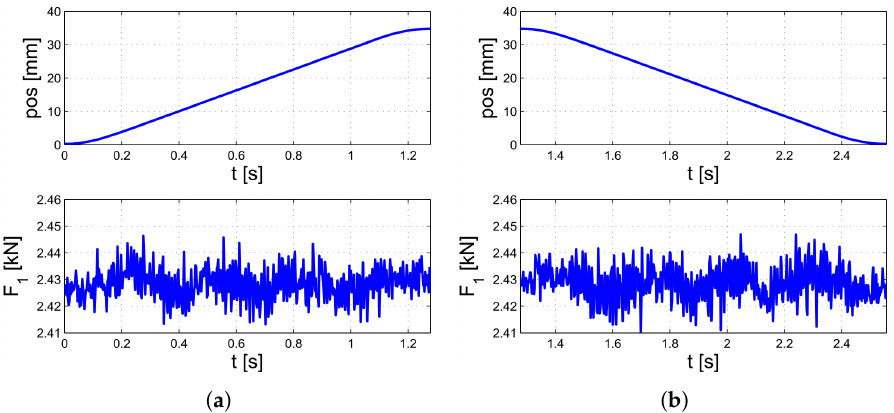
Figure 12. Force measured in one of the four beams duryng a cycle. ( a ) Go phase. ( b ) Return